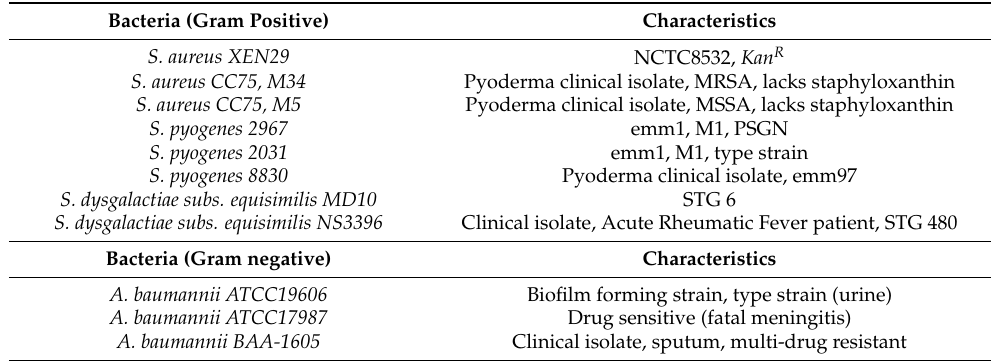
Table 1. Bacterial strains used in this